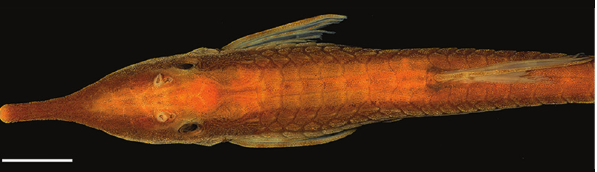
coloration on snout. Scale bar: 5